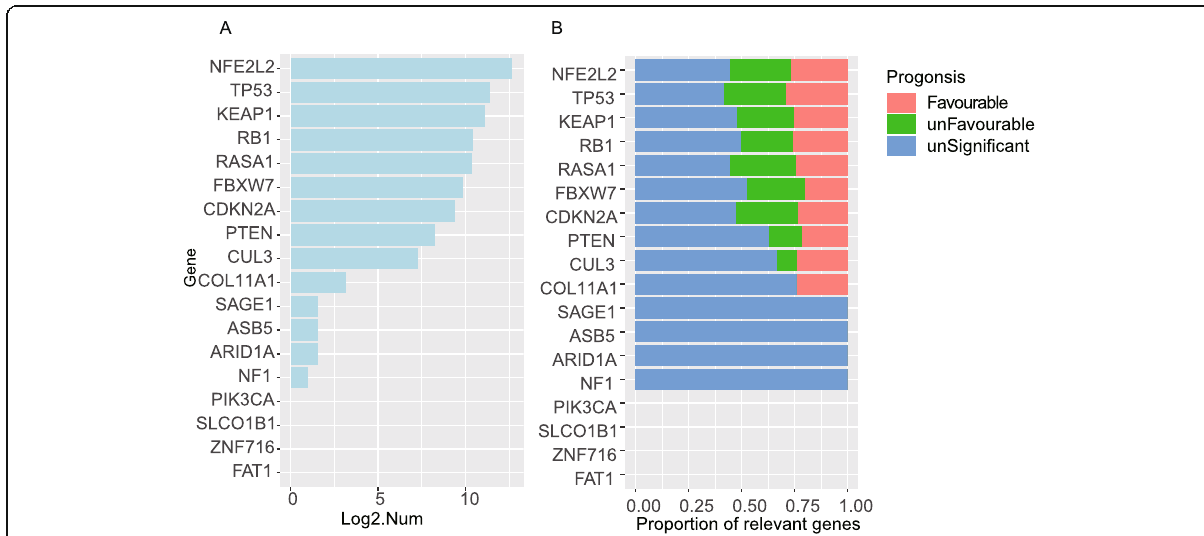
Fig. 2 Somatic mutations generate remarkable down-stream alterations. a . The number of SMG relevant genes which were differentially expressed between samples with and without certain mutation. b . The proportion of SMG relevant genes with different prognostic